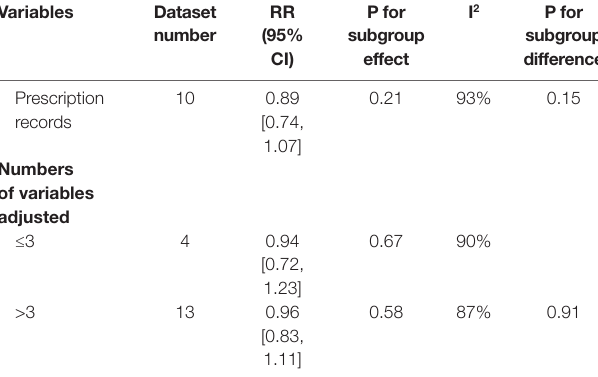
TABLe 3 | Subgroup analysis for the association between thiazides use and the risk of